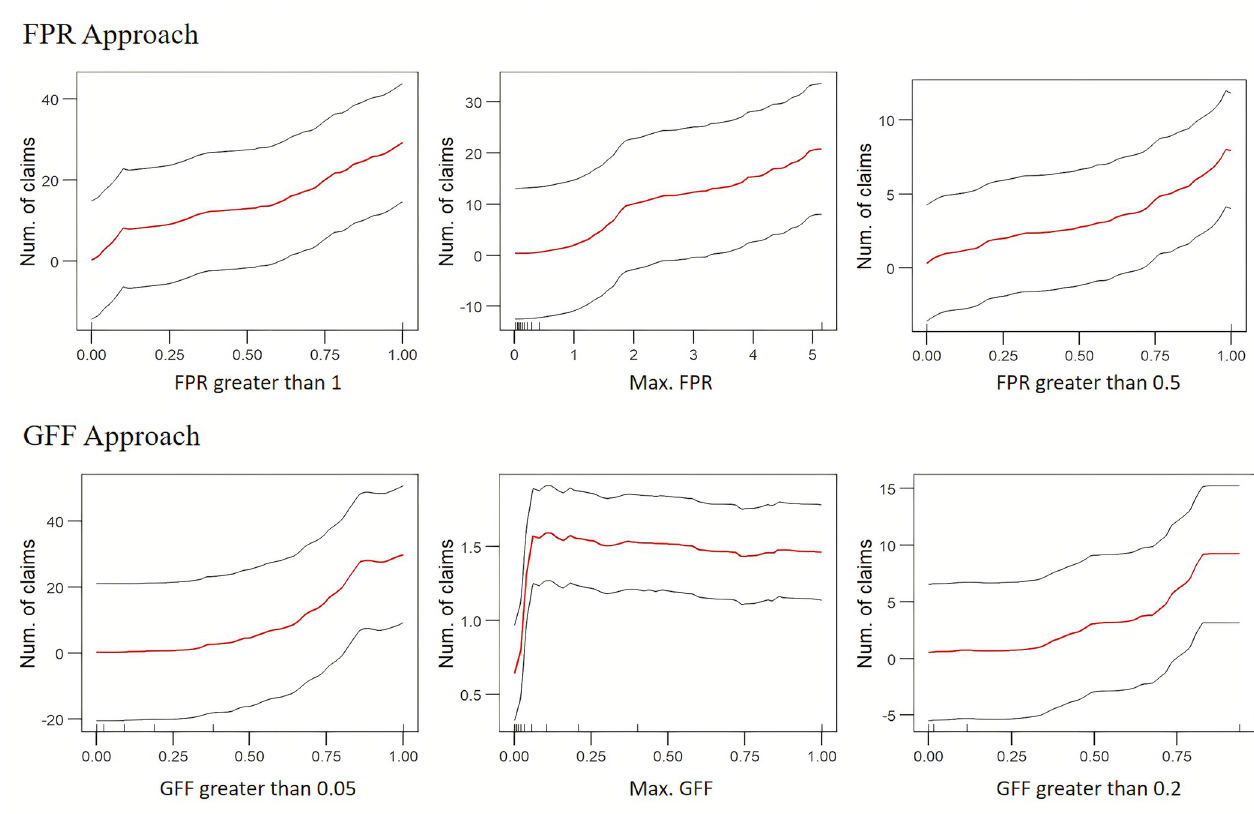
Fig 4. Partial dependence plots of top three important variables for both the FPR model and the GFF model. See S1 Table for a description of